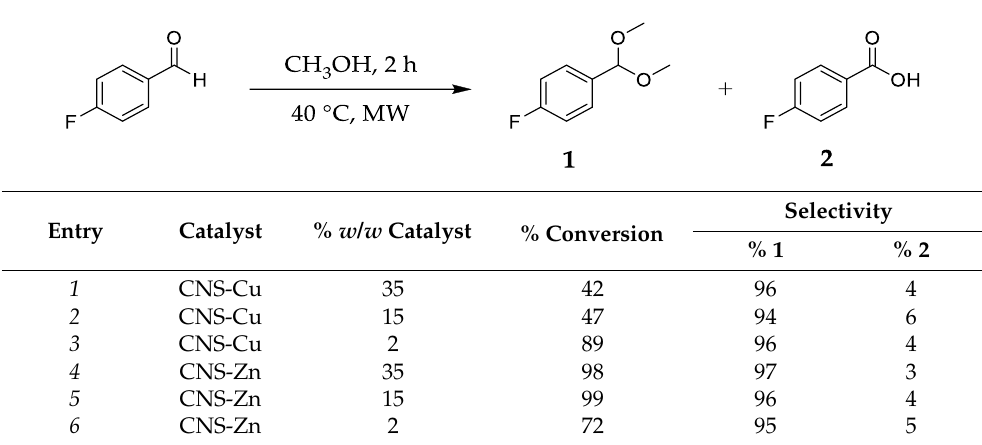
Table 4. Optimization of the % w / w of CNS-Cu and CNS-Zn a .